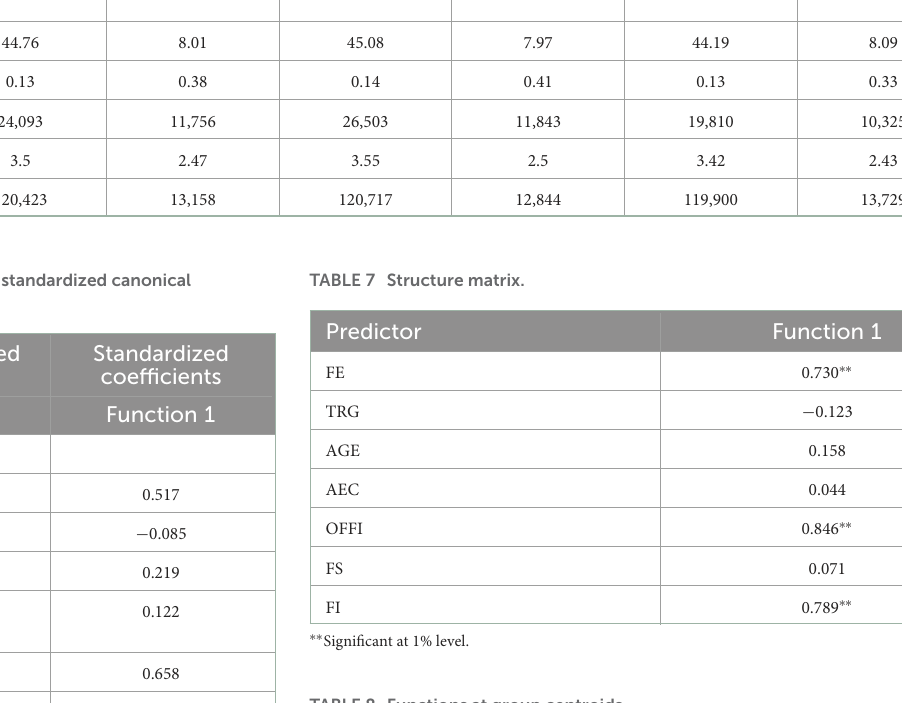
TABLE 8 Functions at group